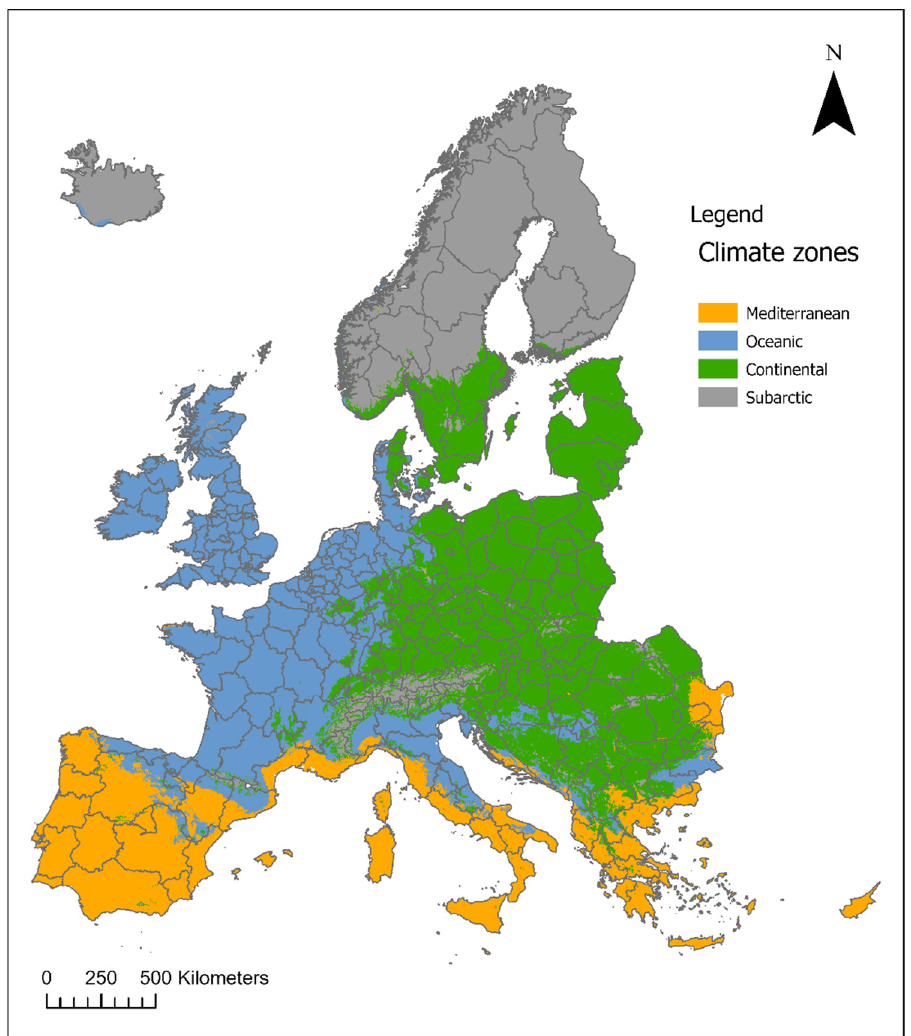
Figure 4. Climate zones as used in SoilCare to vary crop calendars by agroclimatic zone.